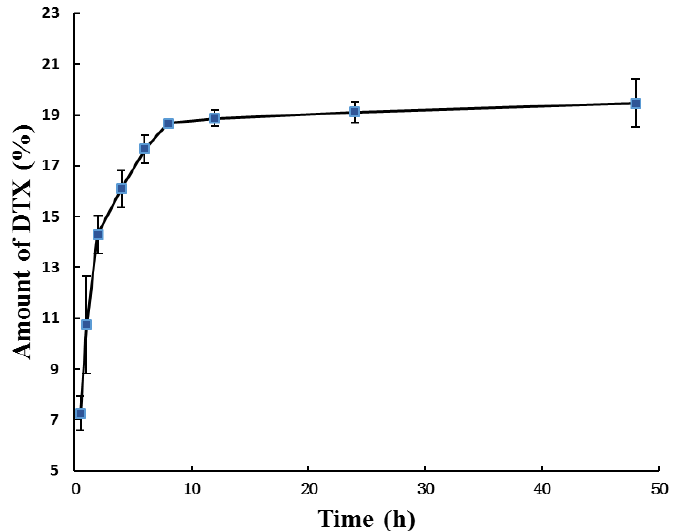
Figure 6. Stability of P123-DTX conjugate micelles following incubation in mouse plasma